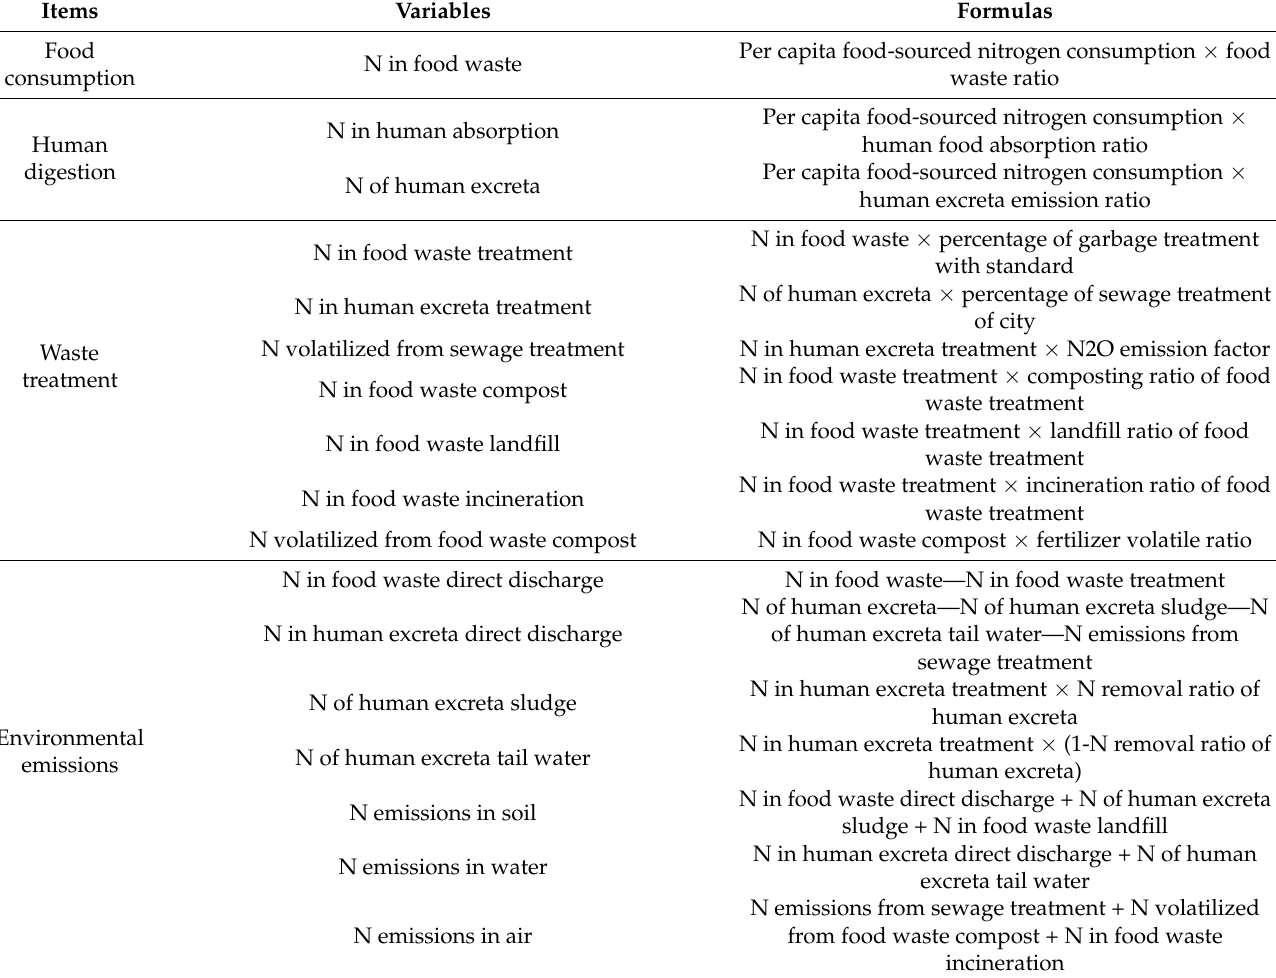
Table A1. Calculation formulas of food-sourced nitrogen metabolism and environmental nitrogen